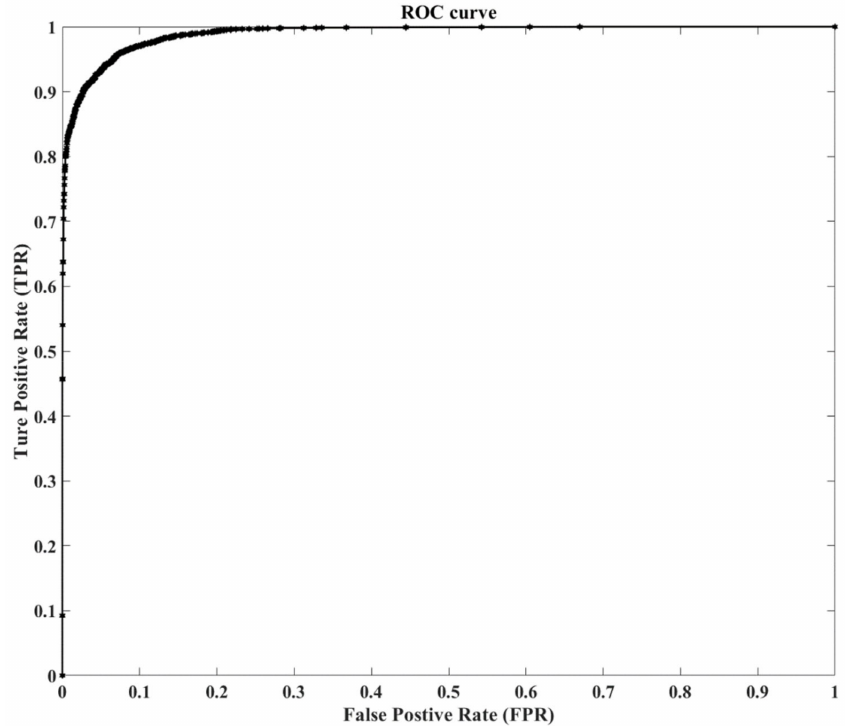
Figure 8. ROC curve of the ViT